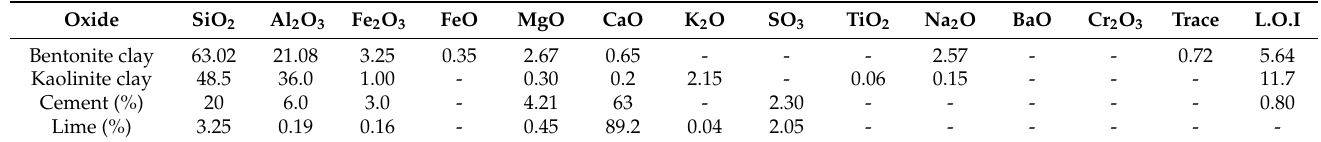
Table 2. Oxide and some of the chemical composition of the bentonite and kaolinite clays.